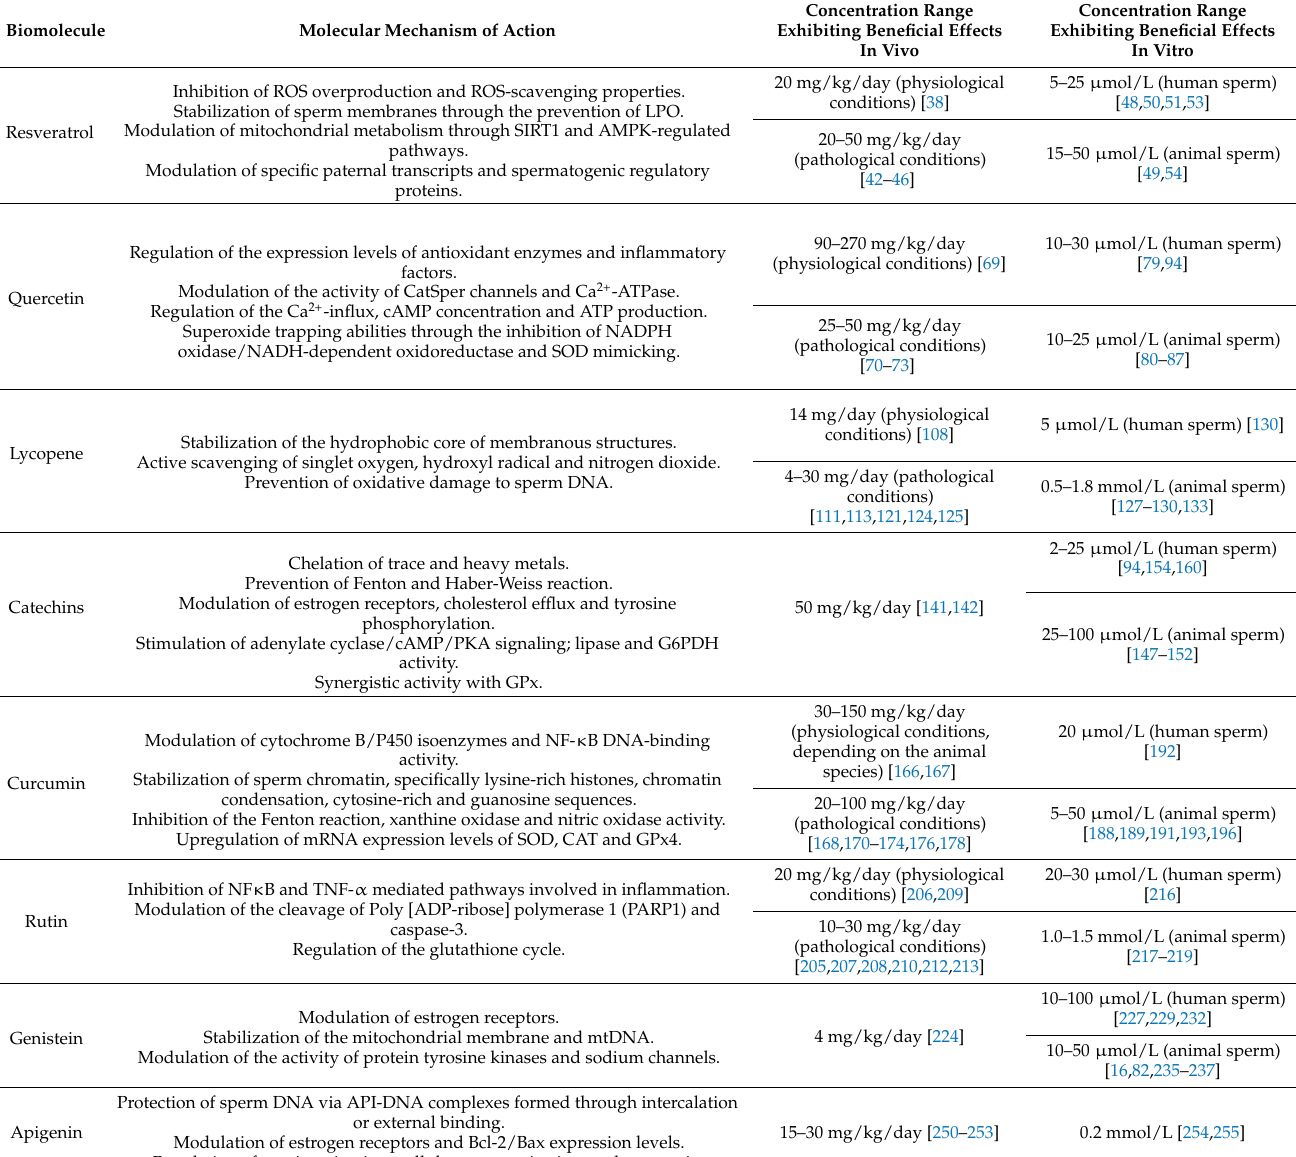
Table 1. Principal mechanisms of action and recommended concentrations of selected biomolecules for in vivo and in vitro